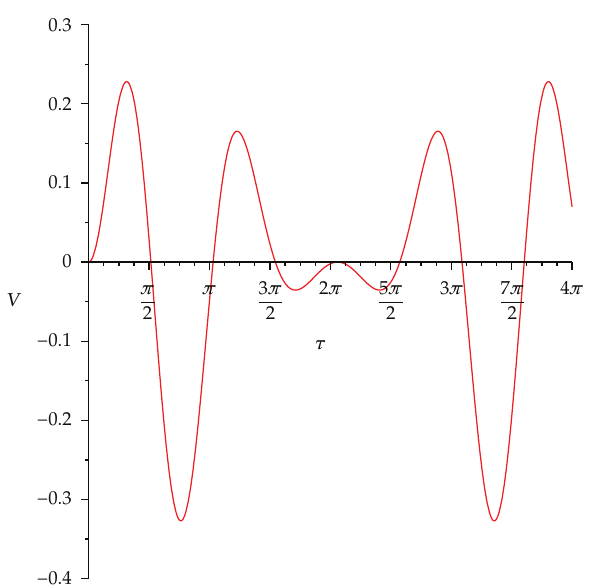
Figure 33: The evolution of the volume of the trefoil knot universe with respect to the cosmic time τ for (cid:2) 5.28 (cid:3)